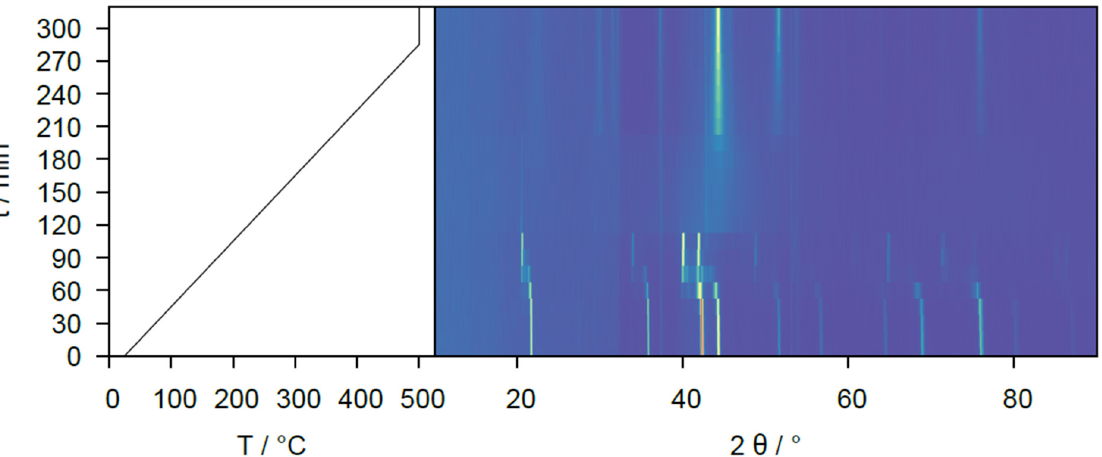
Figure 6. In situ X-ray powder diffraction of Ca x Mg 1 − x Ni 2 ( x = 0.67) under 0.3 MPa hydrogen gas flow (15 sccm), data collected on a Rigaku SmartLab diffractometer in an Anton Paar XRK 900 Reactor Chamber using Cu-K α 1 radiation, sample heated in 20 K steps for 25 ◦ C ≤ T ≤ 500 ◦ C with a 30 K · min –1